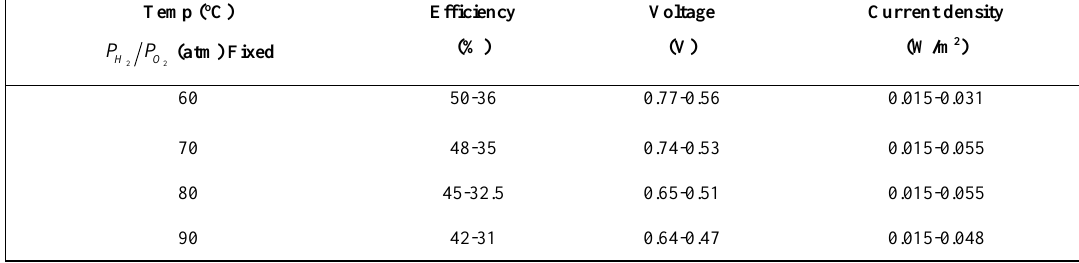
Table 7. Performance of single PEMFC at constant reactants flow pressure and temperature